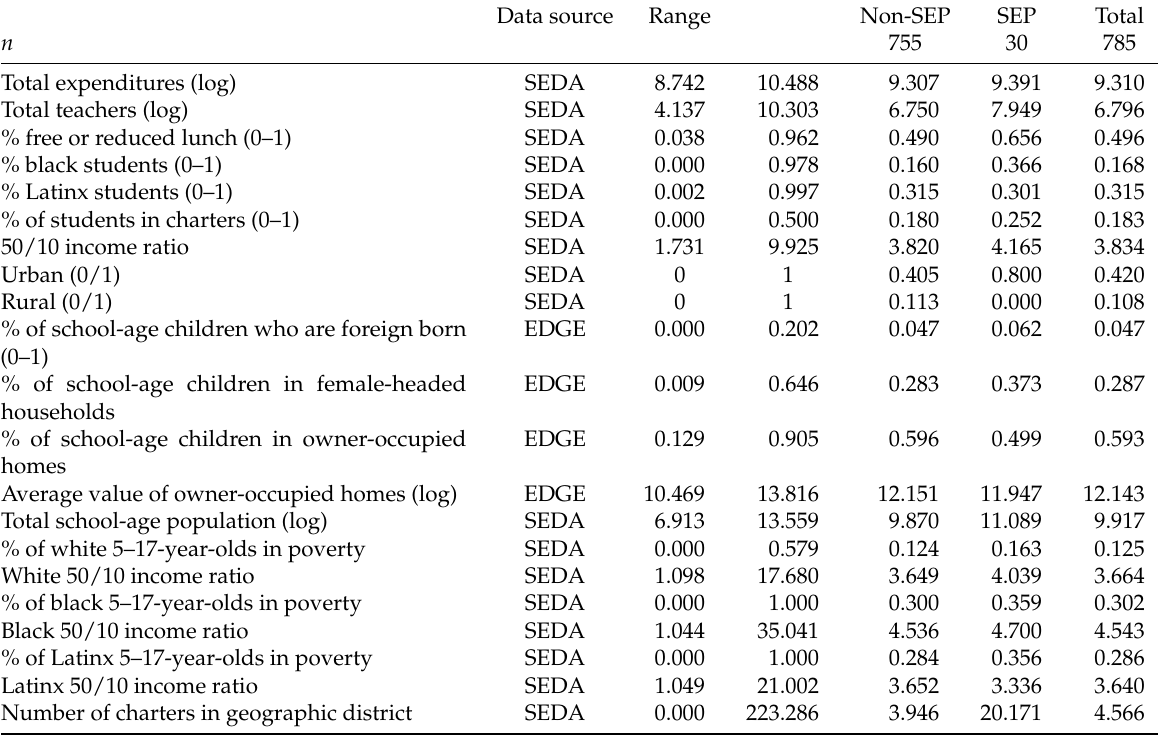
Table 2: Control variables with third grade (pretreatment) descriptive